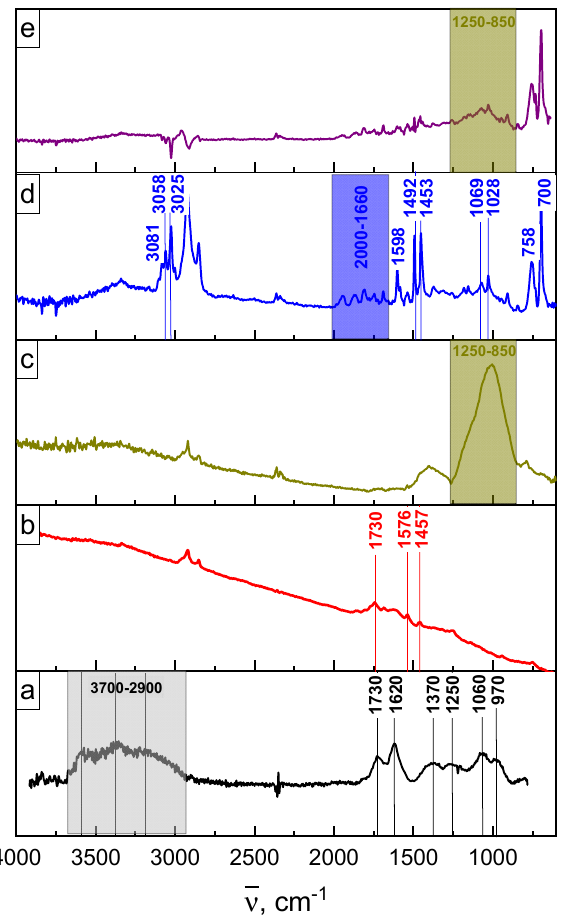
Figure 4. FTIR spectra of graphite oxide ( a ), UV-rGO flakes ( b ), UV-rGO flakes modified with TMSPM ( c ), PS/UV-rGO@TMSPM composite ( d ) and the difference between composite and PS matrix ( e ).